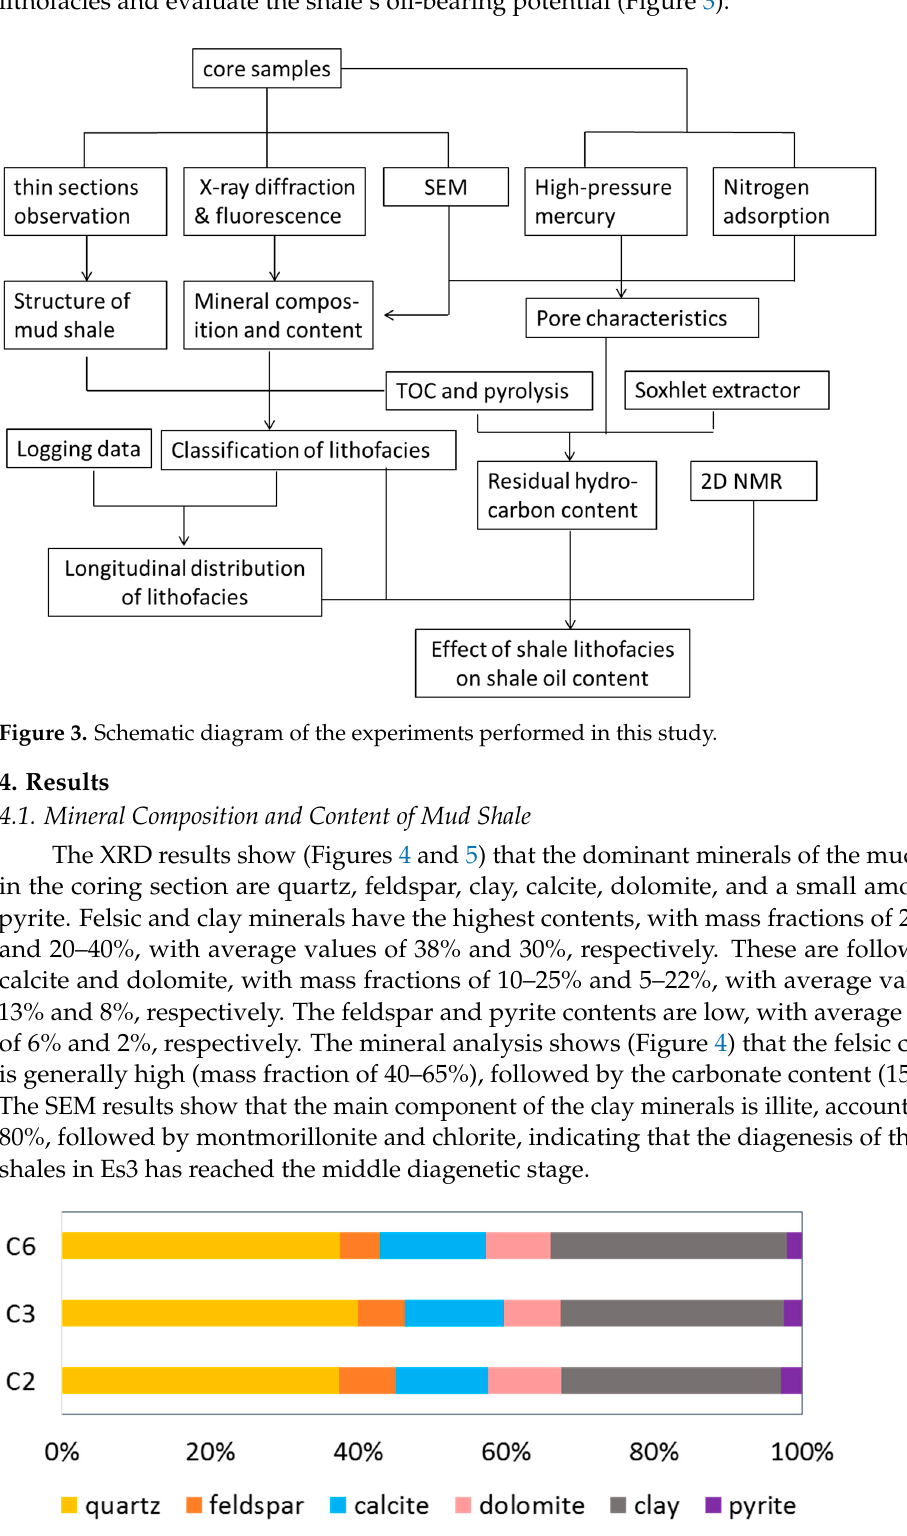
Figure 5. Ternary diagram of shale mineral at different depths in the upper part of Es3 in well F39x1. 4.2. Macro and Microstructure of Mud Shale The structure of the fine-grained sediments, such as the mud shale, indicates that the laminae or bedding is relatively well developed. Different classification schemes have been used to categorize lamina according to their thickness and shape [29–31]. Ingram (1954) categorized them into ultra-thin lamina with a thickness of less than 3 mm, thin laminae (3 mm – 1 cm), medium laminae (1 – 3 cm), and thick laminae (3 – 10 cm). Campbell (1967) categorized the laminae based on the morphology, into uniform, wavy, and curved laminae. Each category was further divided into continuous parallel, intermittent parallel, continuous non-parallel, and intermittent non-parallel laminae. Liu et al. divided the la- custrine shale of the Yanchang Formation in the Ordos Basin into bright and dark layers. The former contained primarily quartz and plagioclase, and the latter consisted of quartz and illite [32 , 33]. The core observations in this study show that the shale laminae of the Es3 in the Qikou Depression are relatively well developed, primarily in the horizontal direction, and the thickness of a single lamina is 0.1 mm – 10 cm. Therefore, we categorized the laminae into thin laminae (average thickness of less than 10 mm) and thick laminae (thickness of 10 mm – 10 cm). When the thickness exceeds 10 mm, the lamination charac- teristics cannot be determined in the thin sections, but the mudstone characteristics of the graded or homogeneous layer are visible, which have great influence on the reservoir space and permeability. When the thickness exceeds 10 cm, the layer is referred to as mas- sive mudstone.